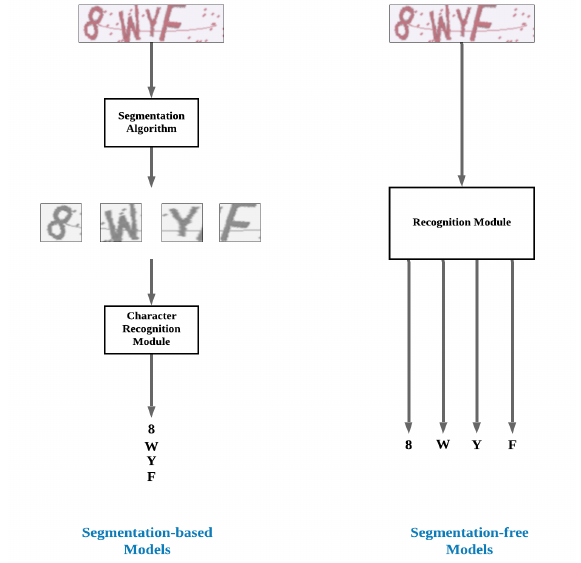
Figure 1. Description of the difference between segmentation-based and segmentation-free CAPTCHA recognition